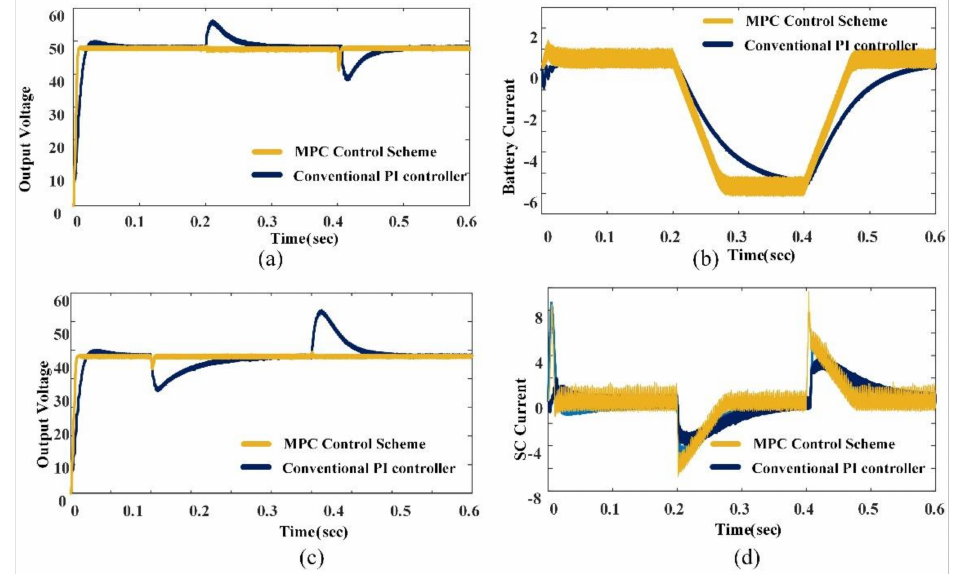
Figure 17. Comparative performance of PI controller over MPC: ( a ) step change in PV, ( b ) battery current, ( c ) step change in load demand and ( d ) SC